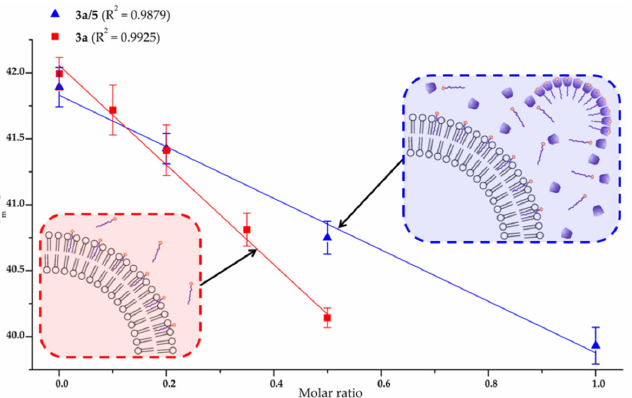
Figure 7. Dependences of the lipid phase transition temperature T m (DPPC) on the amount of 3a (red) and systems 3a/5 (blue) at pH =